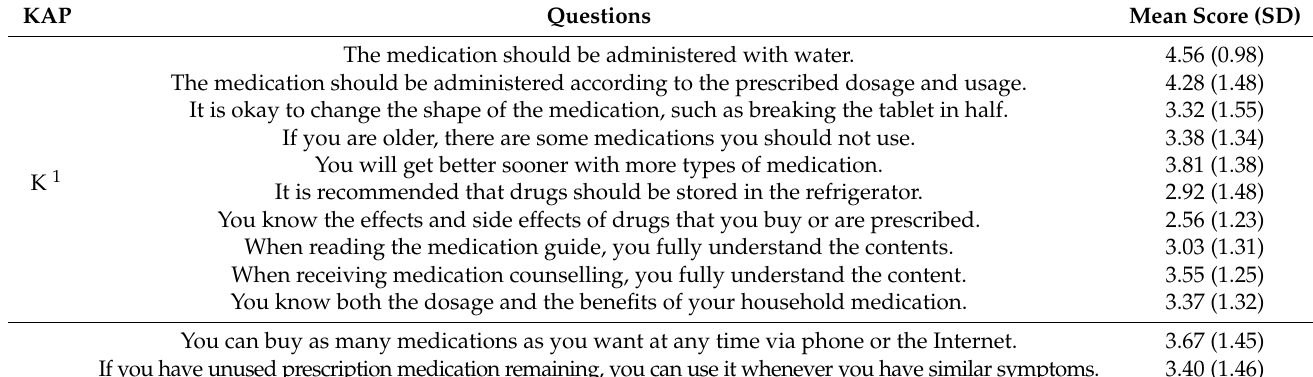
Table 4. Assessment of knowledge, attitude, and practice associated with medication safety ( n = 131). KAP Questions